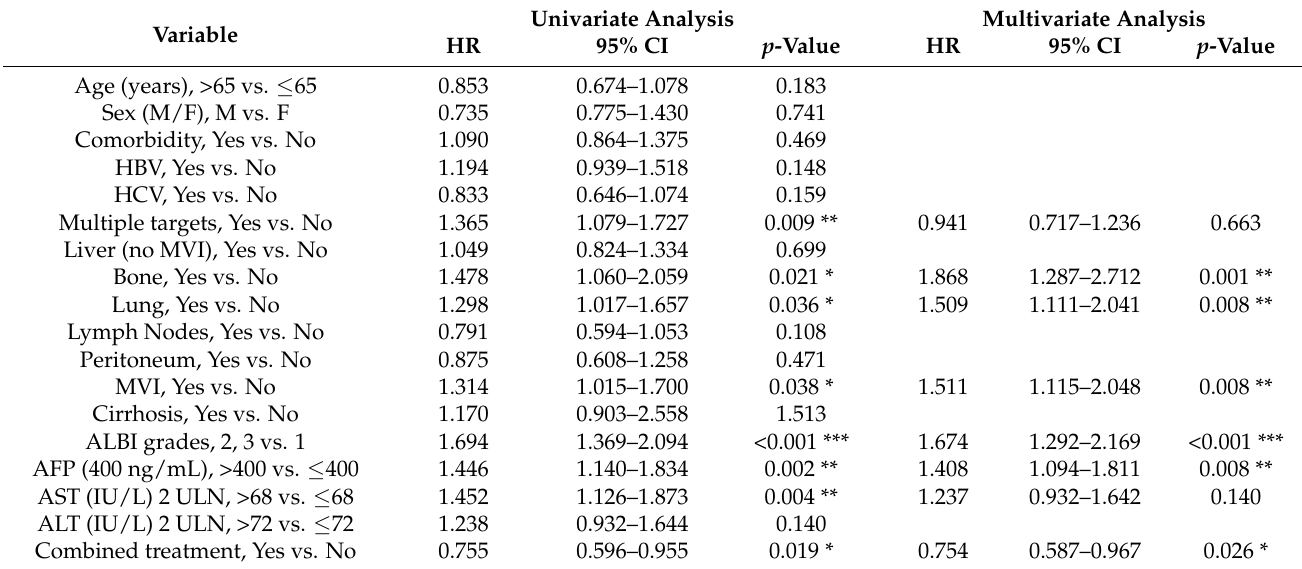
Table 2. Results of univariate and multivariate Cox regression analysis for progression-free survival following sorafenib treatment for 377 advanced HCC patients.